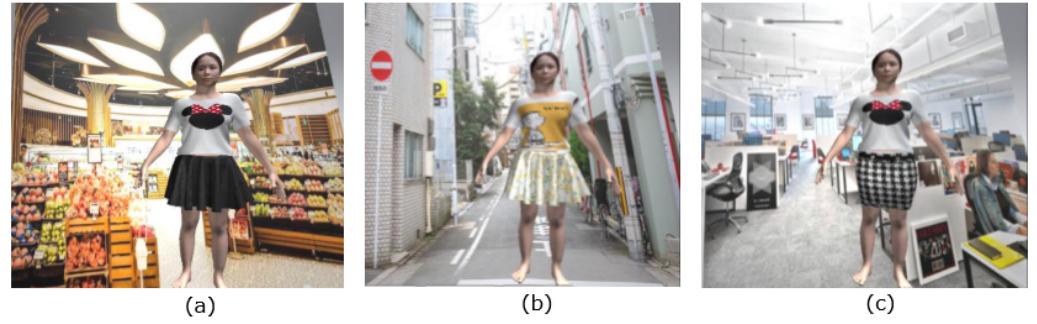
Figure 6. Selectable virtual scenes: ( a ) supermarket, ( b ) street, and ( c )